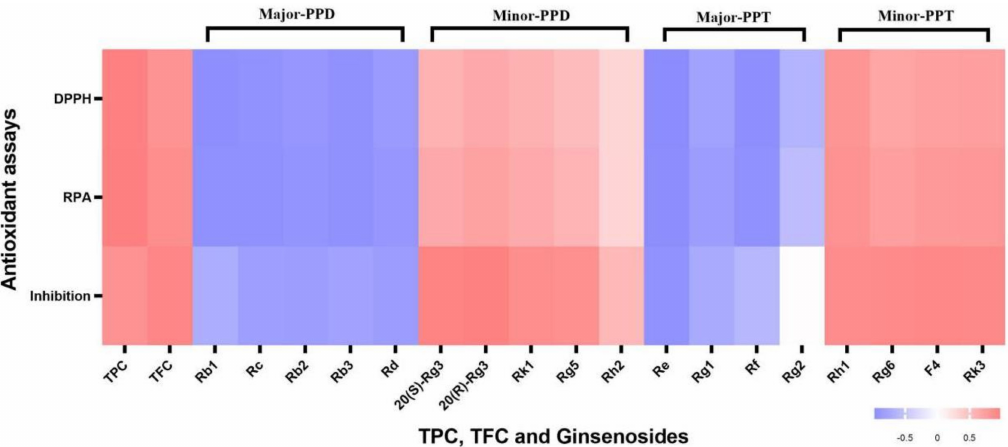
Figure 9. Heatmap of ginsenosides, TPC, TFC and antioxidants activities, including DPPH scavenging, RPA and inhibition. Inhibition meant inhibition of ROS generation at 200 µ g/mL, compared to H 2 O 2 . The square of blue or pink, depending on Pearson’s correlation coefficient values (r), displayed negative ( − 1 < r < 0) or positive (0 < r < 1), respectively. Major-PPD and Major-PPT meant major PPD-ginsenosides and major PPT-ginsenosides,